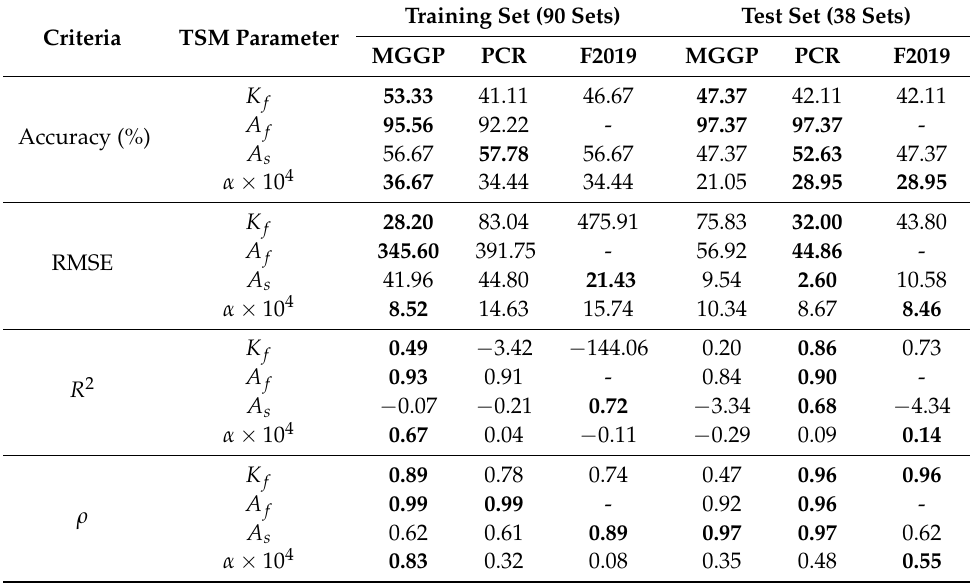
Table 3. Calculated performance criteria of empirical